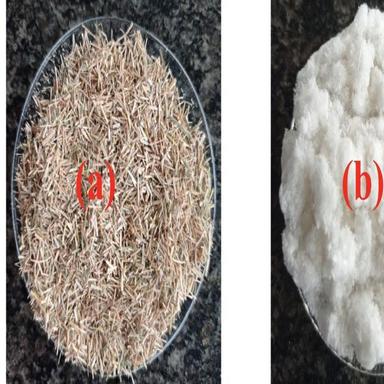
(a) Untreated fibers of MMB and (b) MMC.